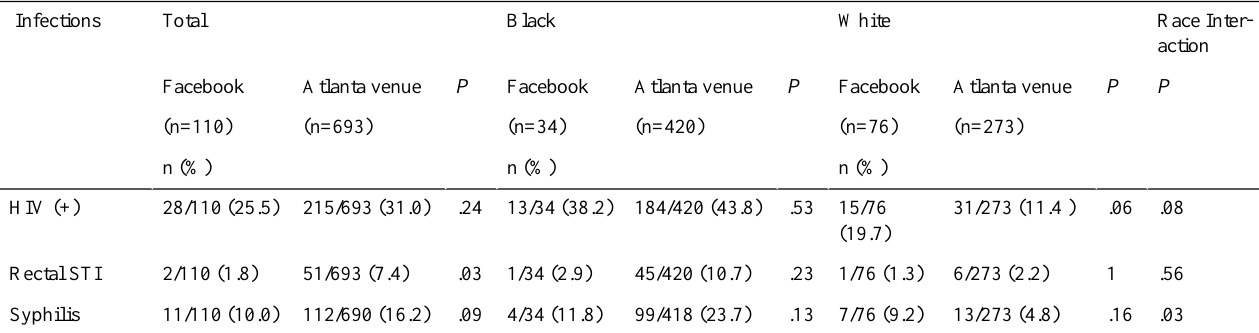
Table 4. HIV and STI prevalence at baseline by recruitment type (Facebook vs Atlanta Venues) and race, InvolveMENt, Atlanta, GA.